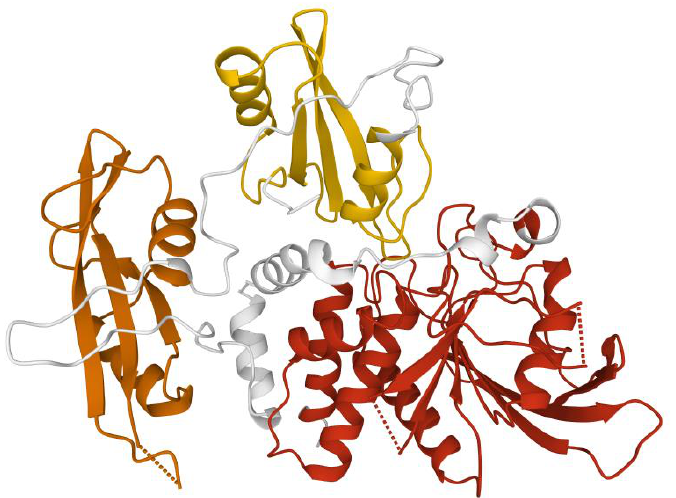
Figure 5. SHP-2 structure. Structure of human SHP-2 lacking the C-terminal tail (66 ammino acid). This closed conformation presents the N-terminal SH2 (yellow), C-terminal SH2 (orange), and the catalytic domain (red). Image created using RCSB PDB (www.rcsb.org accessed on 1 February 2022) and the Mol* application (8) with 2SHP [14].